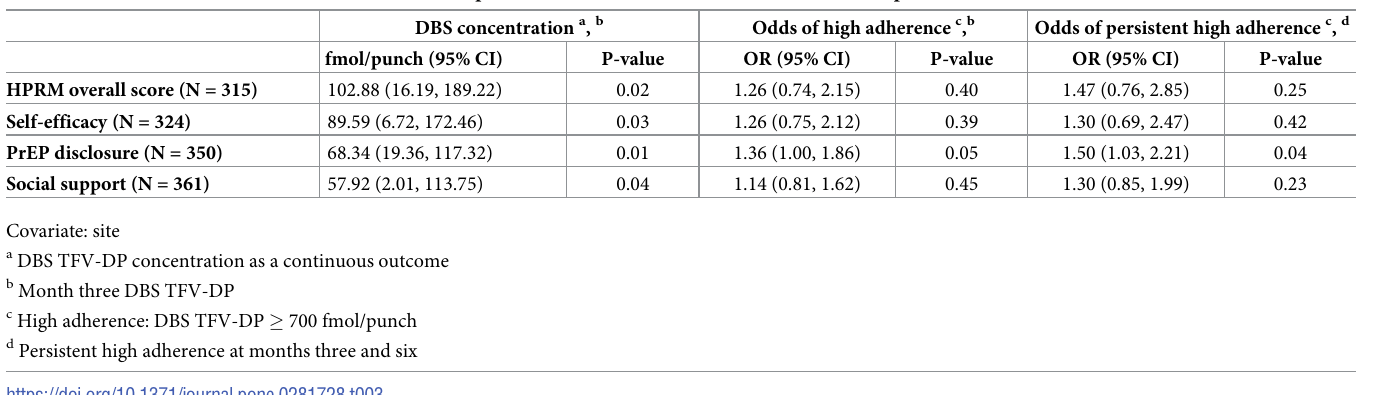
Table 3. Overall HPRM scale and the subscales scores as predictors of PrEP adherence at three months and persistent adherence at months three and